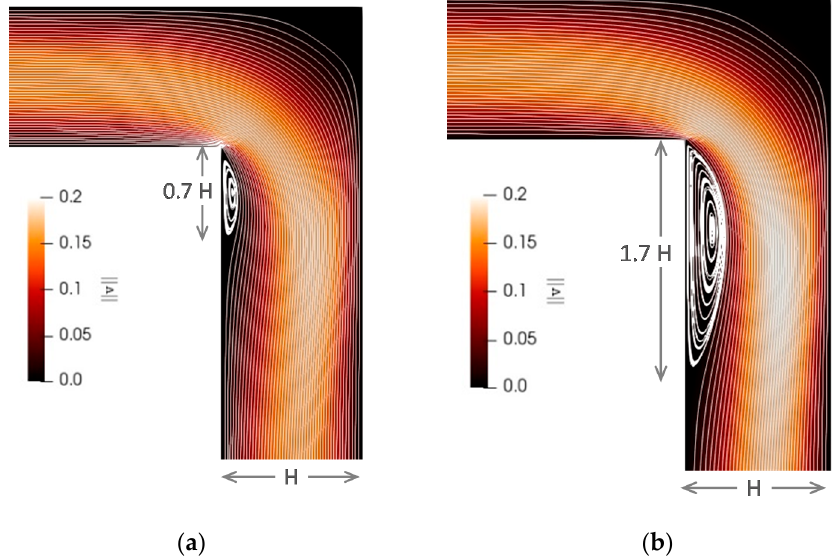
Figure 4. Downstream inertial vortices, Newtonian Flow: ( a ) Reynolds number Re = 50; ( b ) Reynolds number Re = 100.